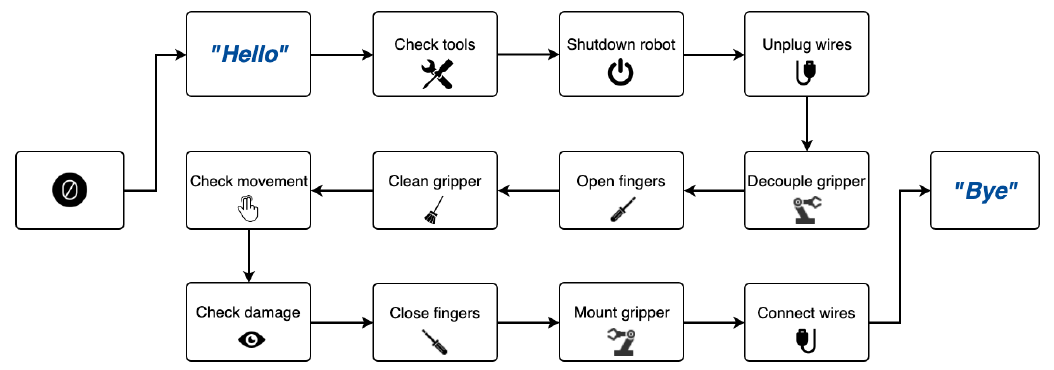
Figure 4. Sequence of steps required to complete the gripper’s maintenance